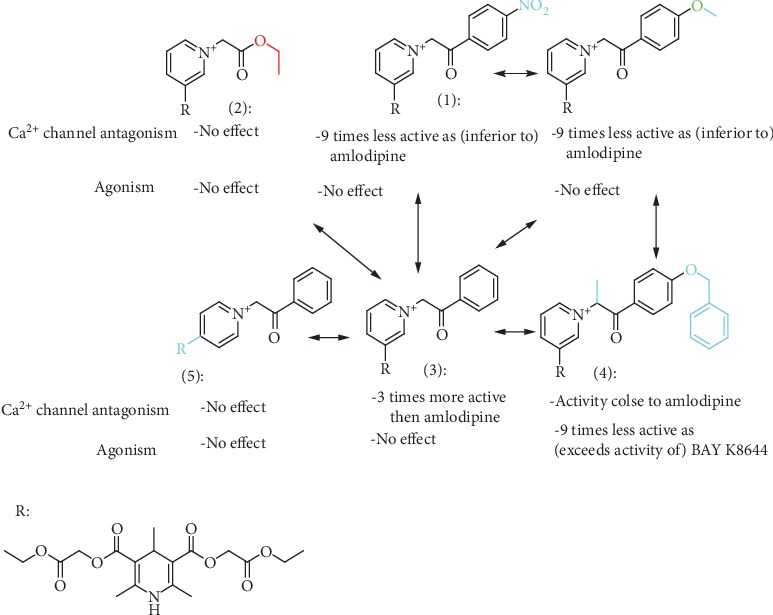
Structure-activity dependence of studied 1,4-dihydropyridines.